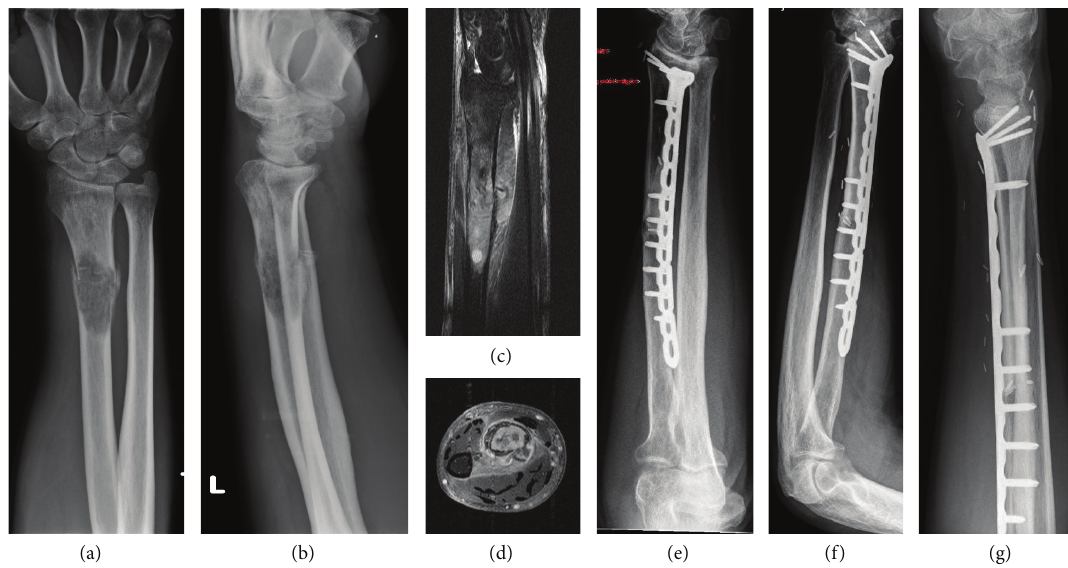
Figure 1: (a–g). Preoperative X-ray (a-b) and MRI (c-d) of a 64-year-old patient with osteosarcoma of the left distal radius; X-ray 22months after replacement with allograft